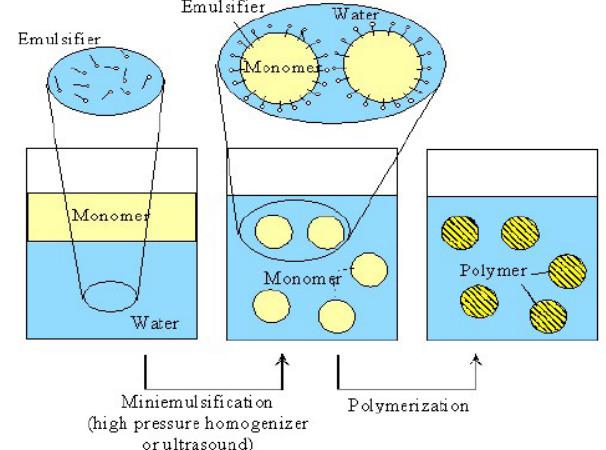
Fig. 3. Principle of miniemulsion procedure [9].